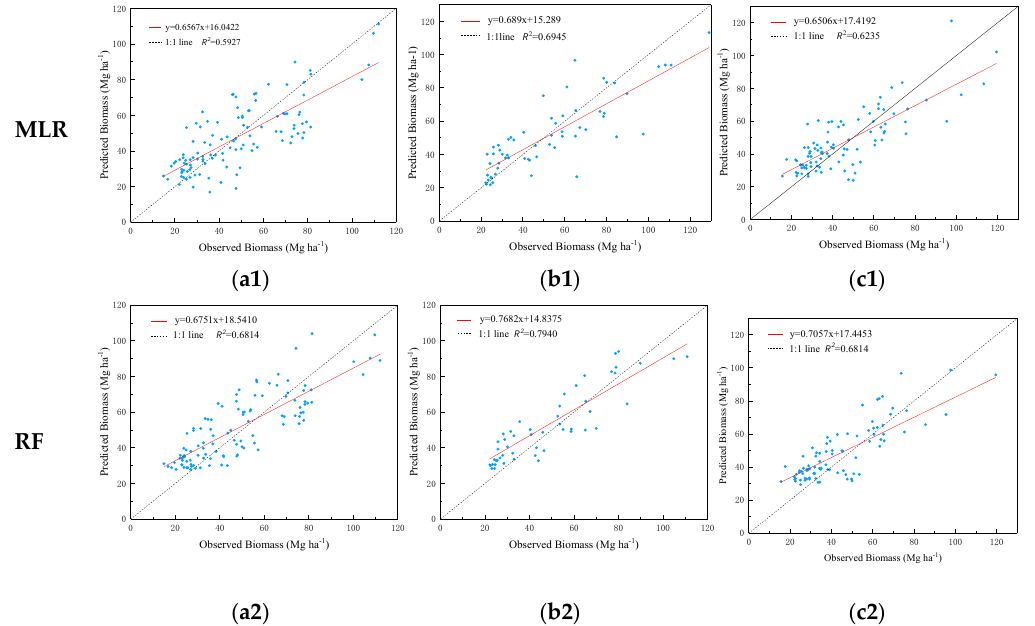
Figure 2. Graphs of the predicted versus observed values of three forest types for two models. ( a1 ) and ( a2 ) Coniferous forest; ( b1 ) and ( b2 ) Mixed forest; ( c1 ) and ( c2 ): Broadleaf forest. Table 6. Estimation accuracy of different